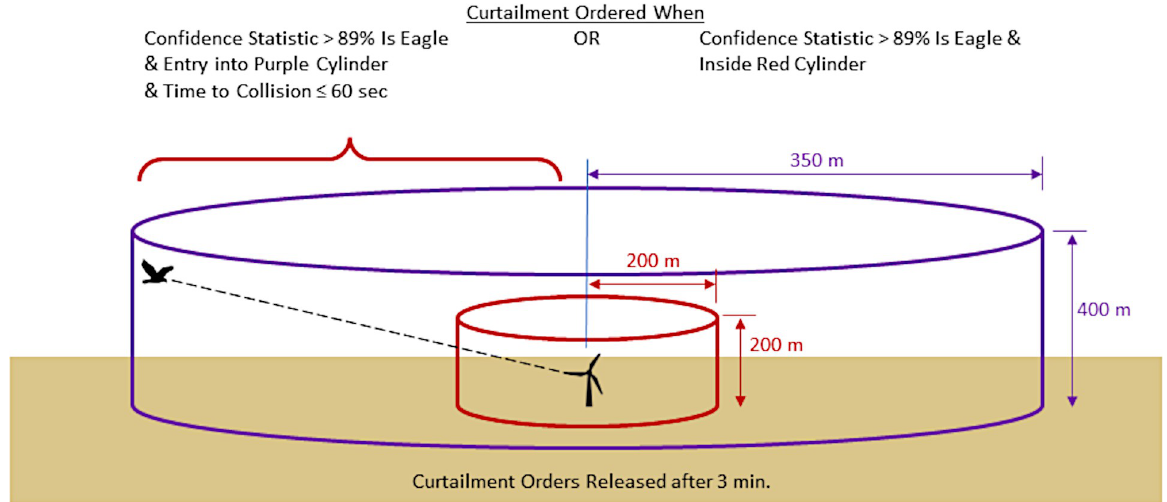
Fig 1. Illustration of the curtailment prescription for the IdentiFlight system installed at Manzana Wind Power Project, California, USA. Curtailments were ordered when the confidence statistic that a target was an eagle > 89% and either the target was within the purple cylinder and heading toward rotor-swept zone (RSZ) such that time to collision � 60 s or the target was within the red cylinder. Curtailments were released 3 min after conditions were no longer met.